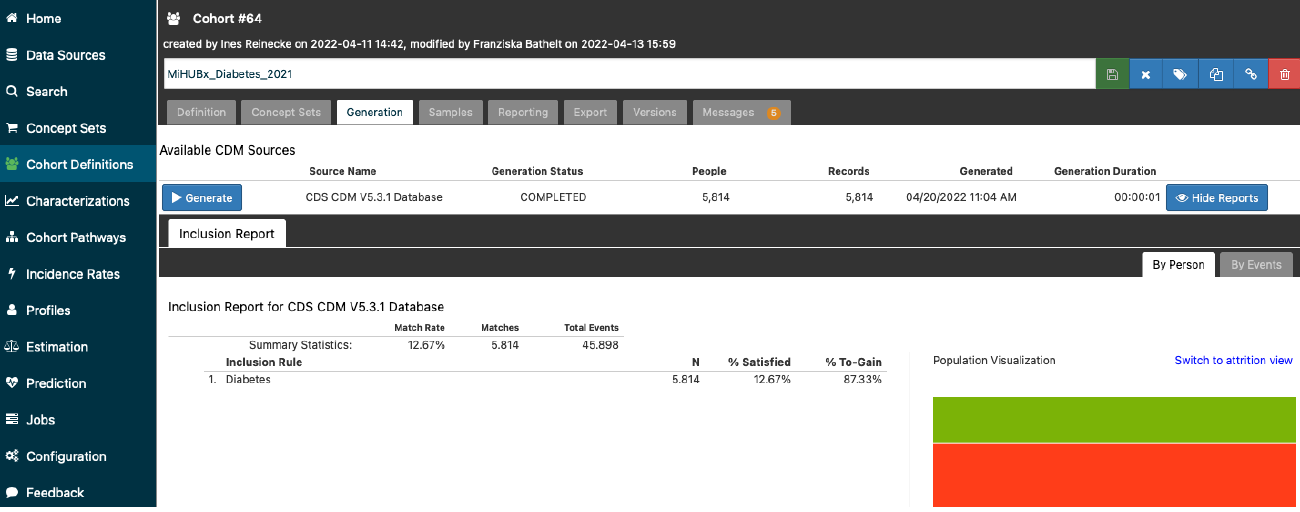
Figure A4. Interface of OHDSI ATLAS—Cohort Generation. The exported cohorts including concept set definitions as JSON files can be found in the Supplementary Materials “File S1”.